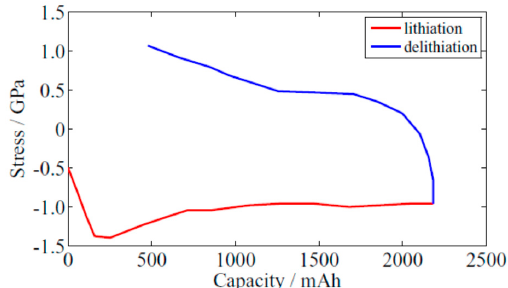
Figure 8. Stress responses of the 100nm Si film electrode [49].